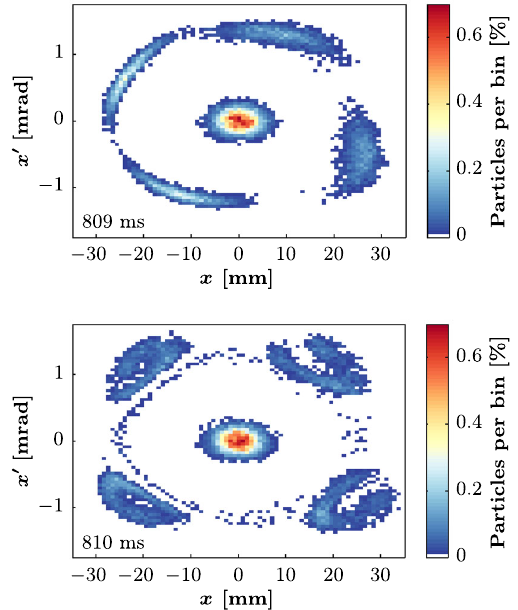
FIG. 16. Simulated horizontal phase space portraits in SS01 during a nonadiabatic final rotation. Once the beamlets are sufficiently separated (see Fig. 7), the rotation occurs within 2000 turns. The top figure shows an intermediate situation after 1000 turns and the phase space in the bottom corresponds to the end of the rotation process. Due to the nonadiabatic rotation de- trapping has occurred, leading to particles captured between the FIG. 15. Dependence of η on the slope (top) and initial MTE core and the islands, and filamentation inside the islands is value (bottom) of the excitation frequency generated by the ongoing. The respective cycle times are indicated in the bottom transverse damper. The color scale provides the information on left corners of the the extraction losses as measured by the BLM in SS16.